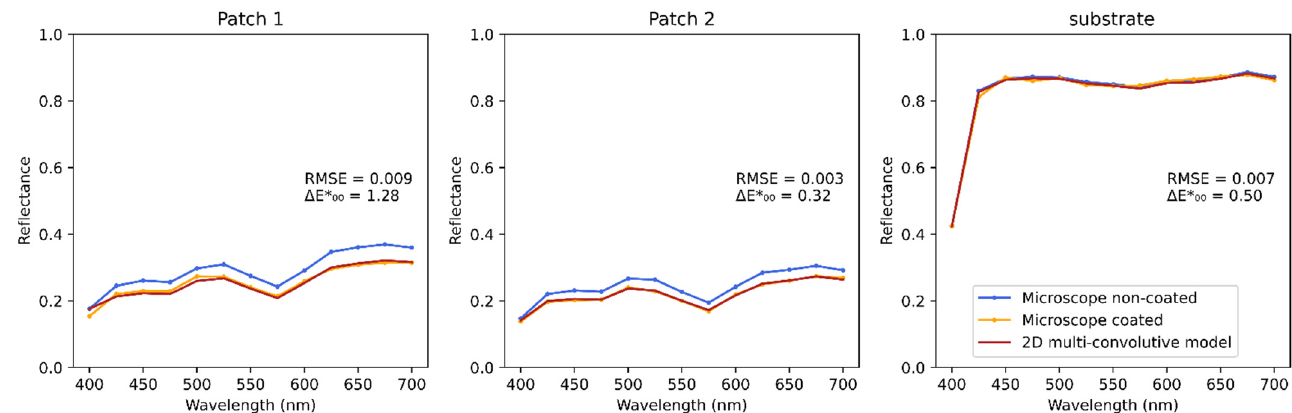
Figure 11. Average spectra of the multi-ink dot halftones, and of the bare substrate.